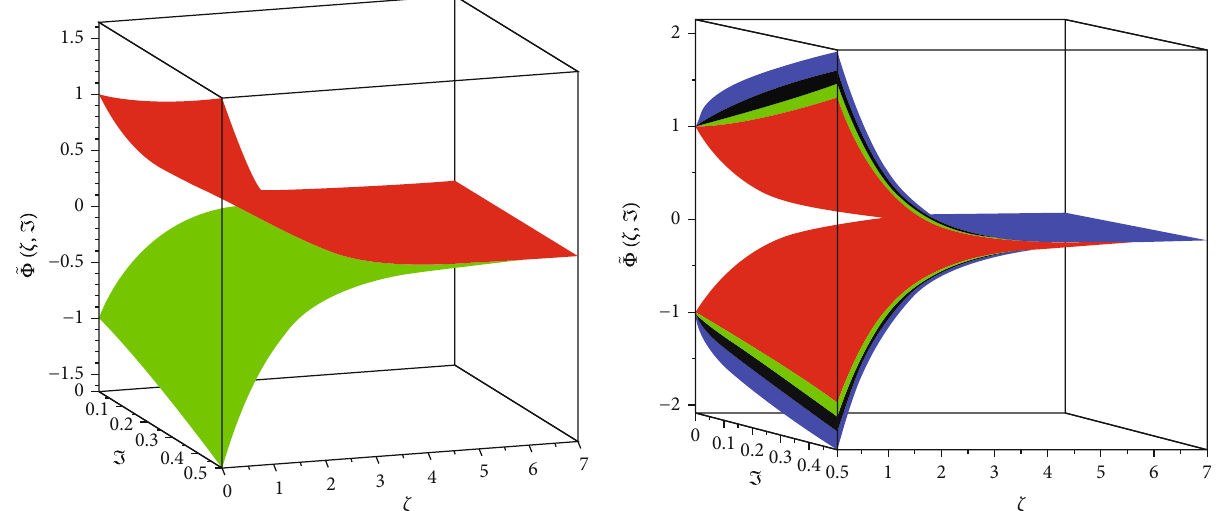
Figure 1: First graph shows that three dimensional fuzzy lower and upper branch graph of analytical series solution and second graph the di ff erent fractional-order of ν